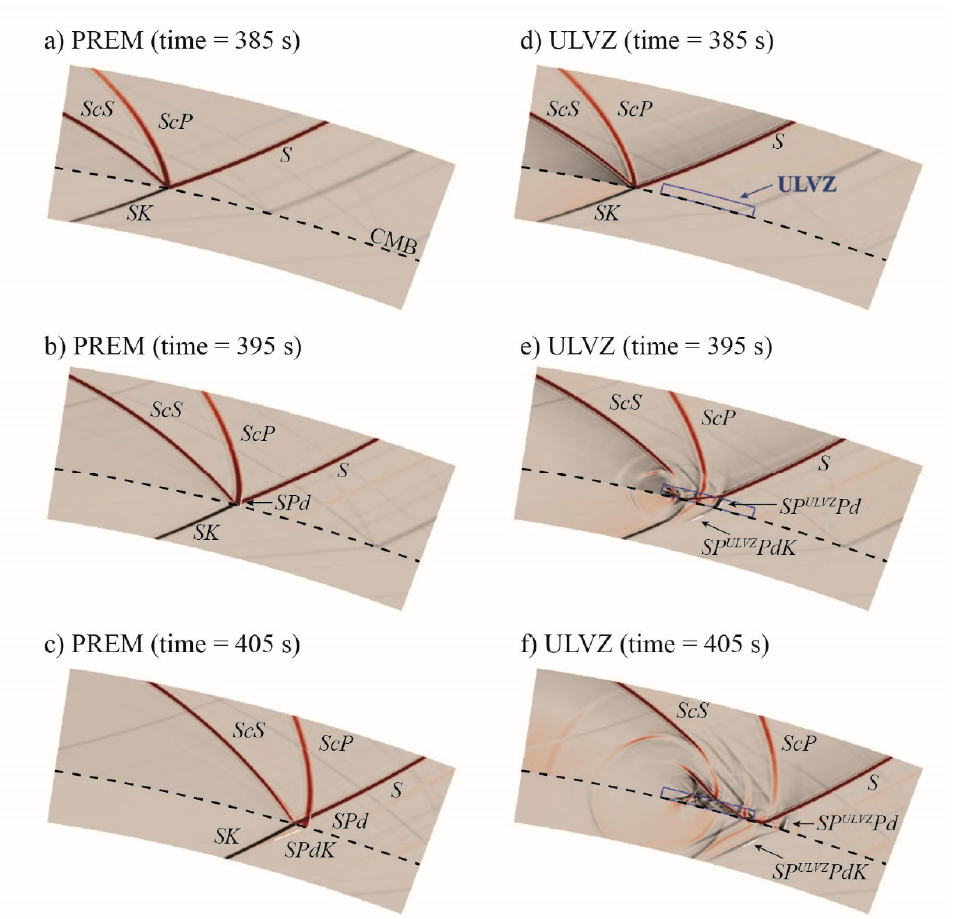
Figure 3. Snapshots of wave propagation in the PREM model (panels a–c ) and a ULVZ model (panels d–f ) at three times (385, 395, and 405 s) after the event origin. Snapshots are shown for a 500 km deep event. The wavefield is centered on a window between − 100 km and + 200 km relative to the CMB and in an angular distance from 10° to 22° relative to the event. The CMB location is shown with the dashed black line. In each panel, the displacement wavefield is shown and individual seismic arrivals are labeled. The position of the ULVZ (panels d–f) is drawn with a blue box. ULVZs are not necessarily the only structural feature that could explain anomalous